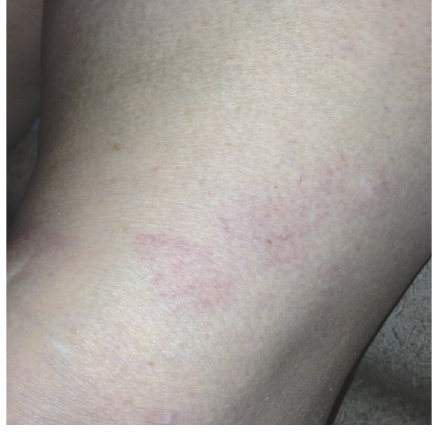
Figure 2: Macular rash over the left